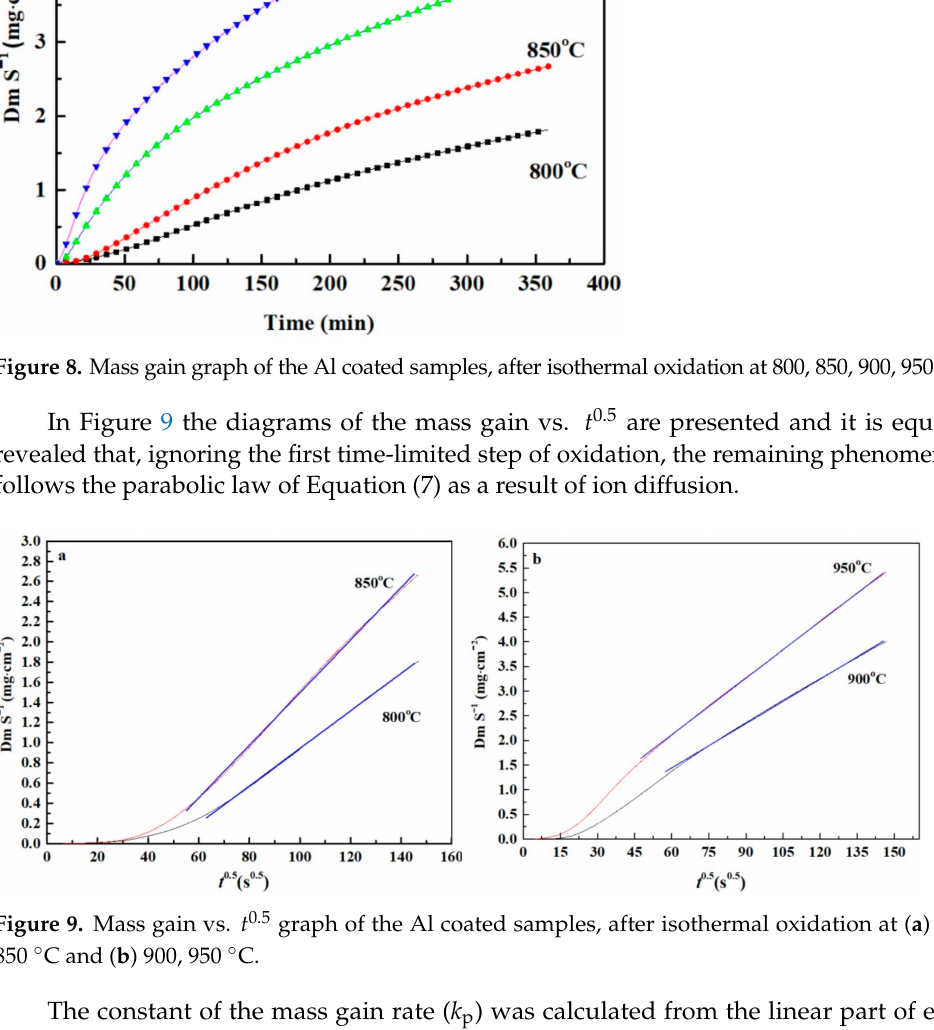
Table 2. Values of the constant of the mass gain rate ( k p ) of Al coated samples for 800,850, 900, 950 ◦ C.